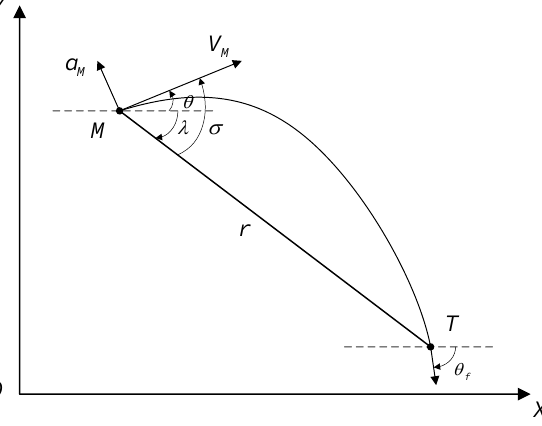
Figure 1. Planar engagement